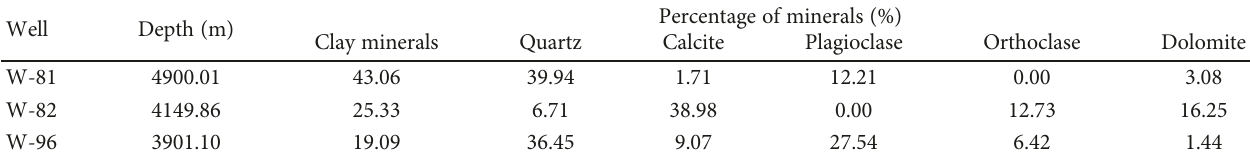
Table 1: Mineral composition of shale.